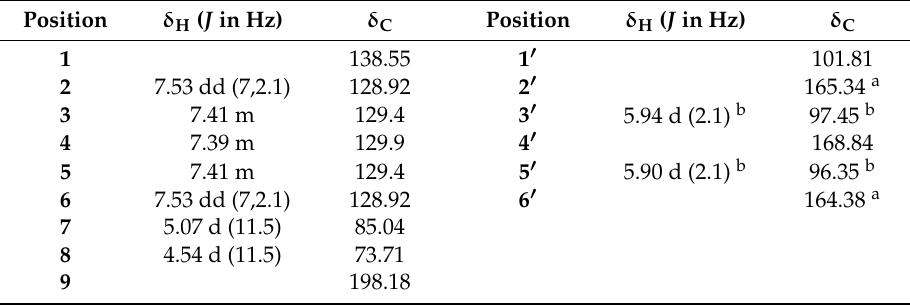
Figure 2. Structure of epoxypinocembrin chalcone 6 and selected EI-MS fragments, and NMR correlations. Table 2. 1 H- and 13 C-NMR chemical shifts of epoxypinocembrin chalcone ( 6 ).